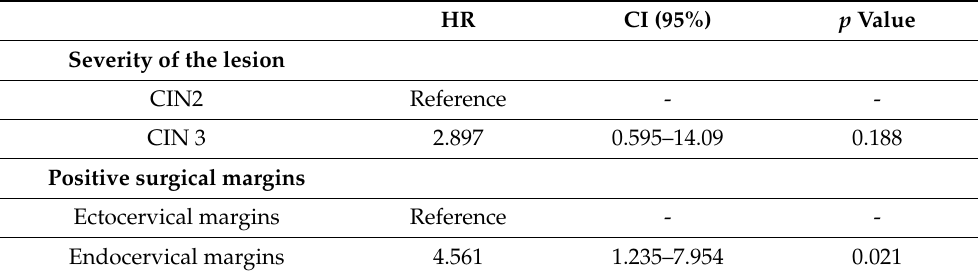
Table 3. Multivariate recurrence of cervical dysplasia